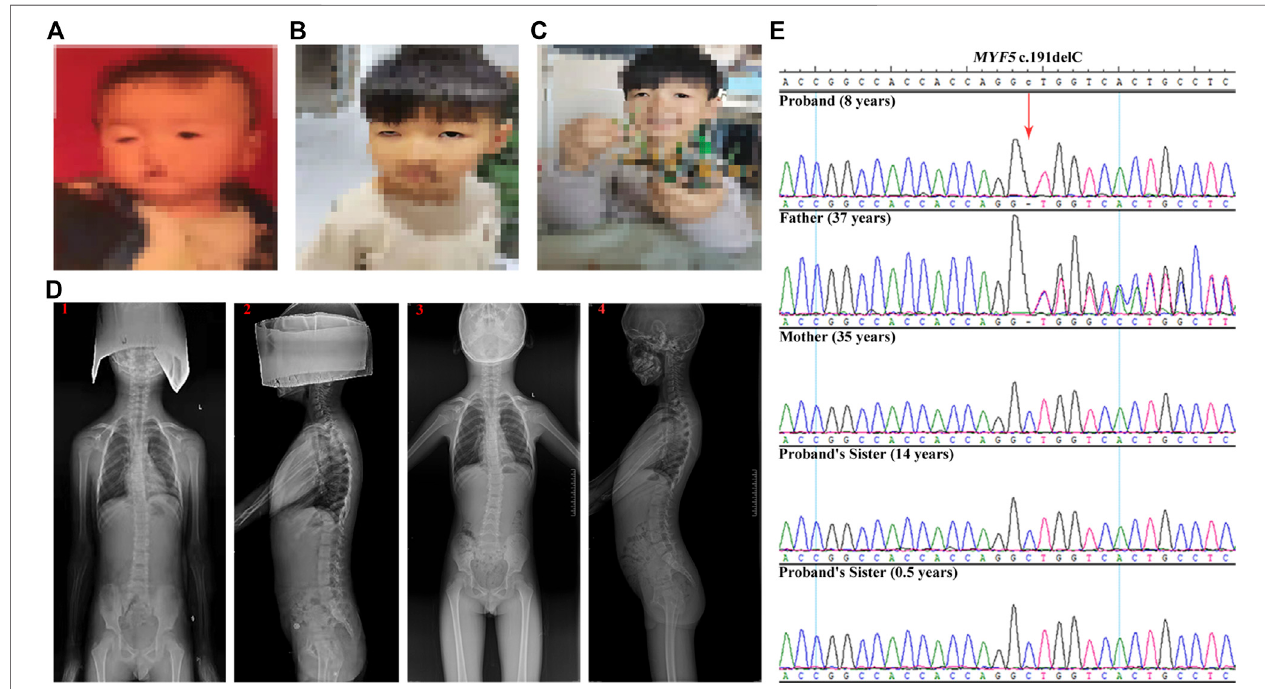
FIGURE 1 | Clinical features of the proband and Sanger sequencing results of the family. (A – C) The ptosis phenotype at birth, at the age of 6 years before the reconstructive surgery, and at the age of 6 years after the reconstructive surgery, respectively, showing the improvement in ptosis symptom for the proband. (D) DR images acquired at the age of 7 years (1 and 2) and at the age of 8 years (3 and 4), showing the signi fi cant aggravation of the scoliosis condition for the proband. (E) Sanger sequencing results of c.191delC for the family. The proband is homozygous. The father is heterozygous, whereas the mother and the two sisters are wild-